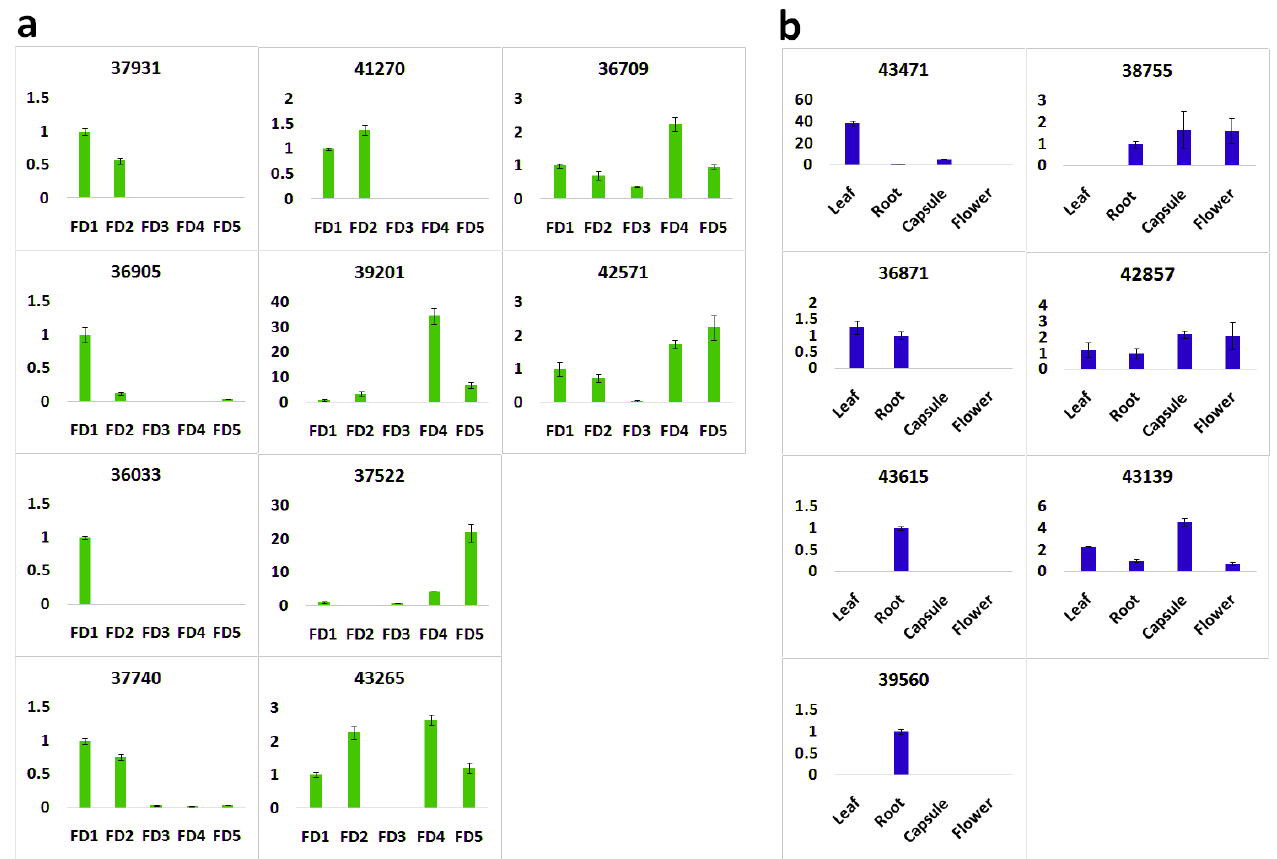
Figure 8. qRT-PCR expressions of selected genes in flower development (FD) stages ( a ) and vegetative tissues ( b ). FD1 to FD5 denotes the flower development stages 1–5. The genes expressed in flower development stages include, 37931 (auxin transporter-like protein), 36905 (Homeobox protein knotted-1-like), 36033 (gibberellin-regulated protein), 37740 (protein YABBY 4-like), 41270 (tubulin beta-2 chain), 39201 (oligopeptide transporter 3-like), 37522 (ubiquinol oxidase), 43,265 (bidirectional sugar transporter), 36709 (ABSCISIC ACID-INSENSITIVE 5-like protein) and 42571 (LOB do- main-containing protein). The genes expressed in vegetative tissues include, 43471 (bidirectional sugar transporter), 36,871 (auxin-responsive protein), 43615 (7-deoxyloganetin glucosyltransferase), 39560 (MADS-box transcription factor 27), 38755 (Flavonoid 3’-monooxygenase), 42857 (Transcription factor MYB39) and 43139 (Protein indeterminate-domain 14).